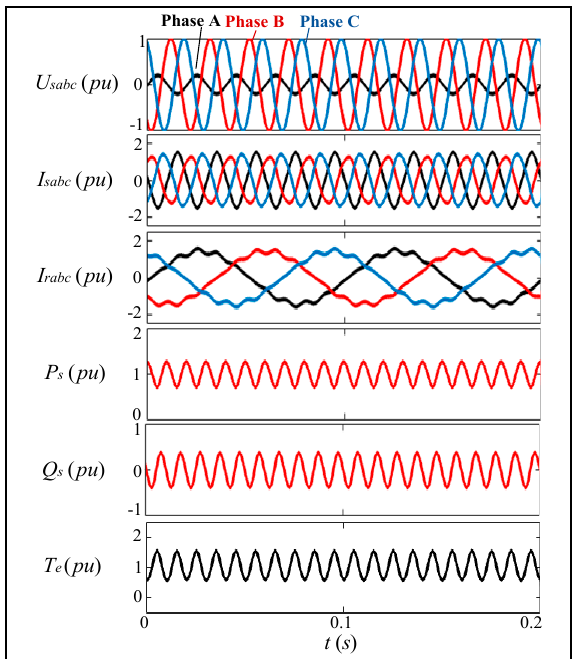
Figure 10. Conventional VSG control under a single-phase grid voltage drop of 80%.